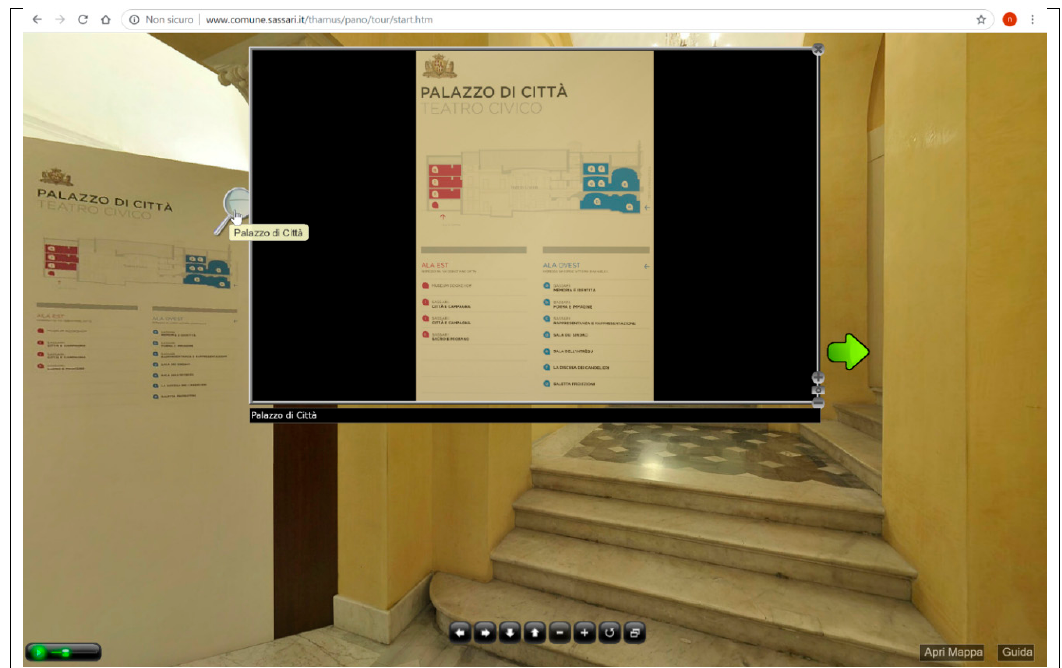
Figure A6: “Palazzo di Città—Teatro Civico (Sassari)”. Command bar, scenes preview, hotspots, link among scenes, floor plan [27].